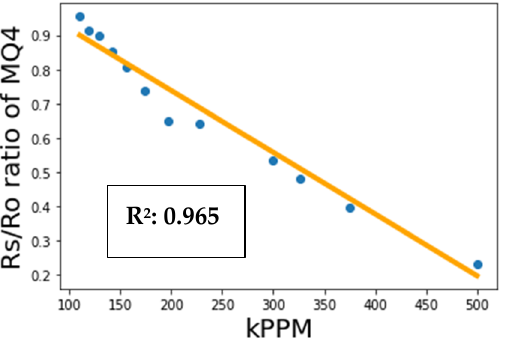
Figure 8. Calibration curve for MQ4 sensor integrated in a device.